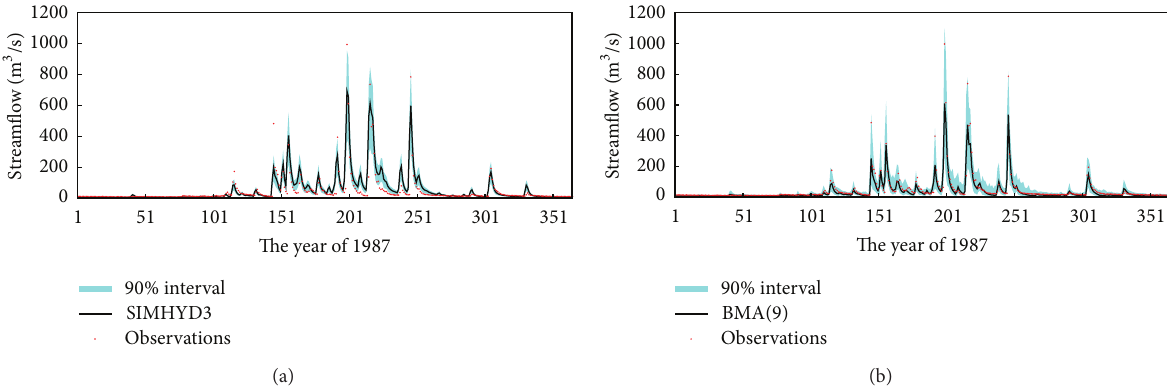
Figure 9: The mean prediction and 90% confidence interval of BMA(9) and SIMHYD3 model (the SIMHYD with the objective function OF3) for the Mumahe catchment in 1987 during the validation period.